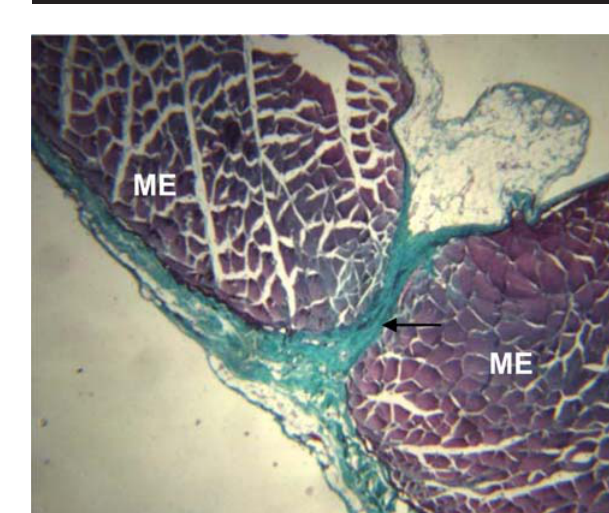
FIGURA 3 - Fotomicrografia do plano músculo-aponeurótico abdominal de rato (subgrupo controle de 28 dias), em que se vê parte do saco herniário (SH), com fibras colágenas, em azul, adjacente ao tecido muscular estriado (ME), em vermelho (objetiva de x4, Gomori).